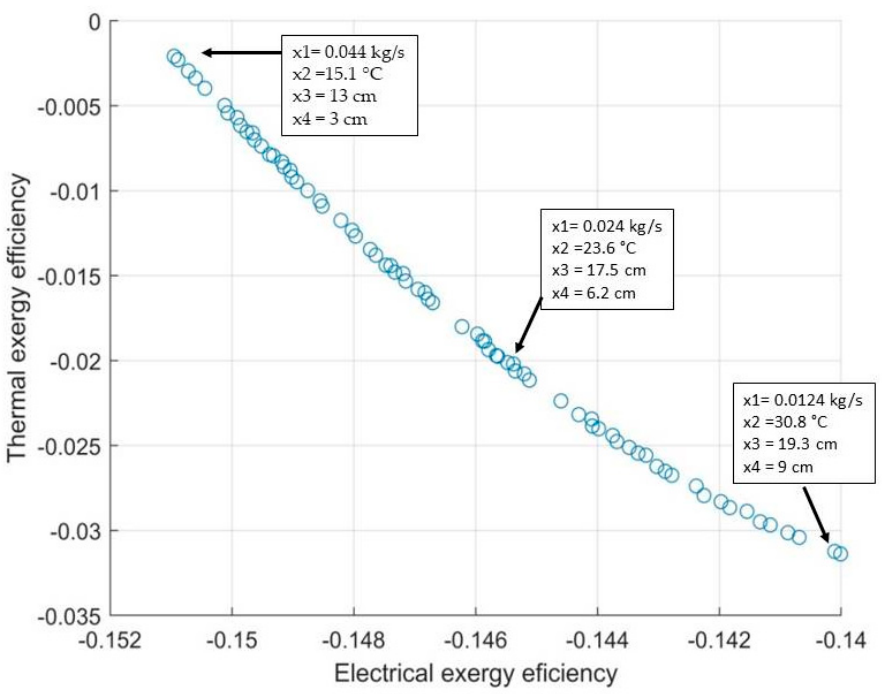
Figure 16. The Pareto optimal front in the objective space of the electrical and thermal exergy efficiencies.